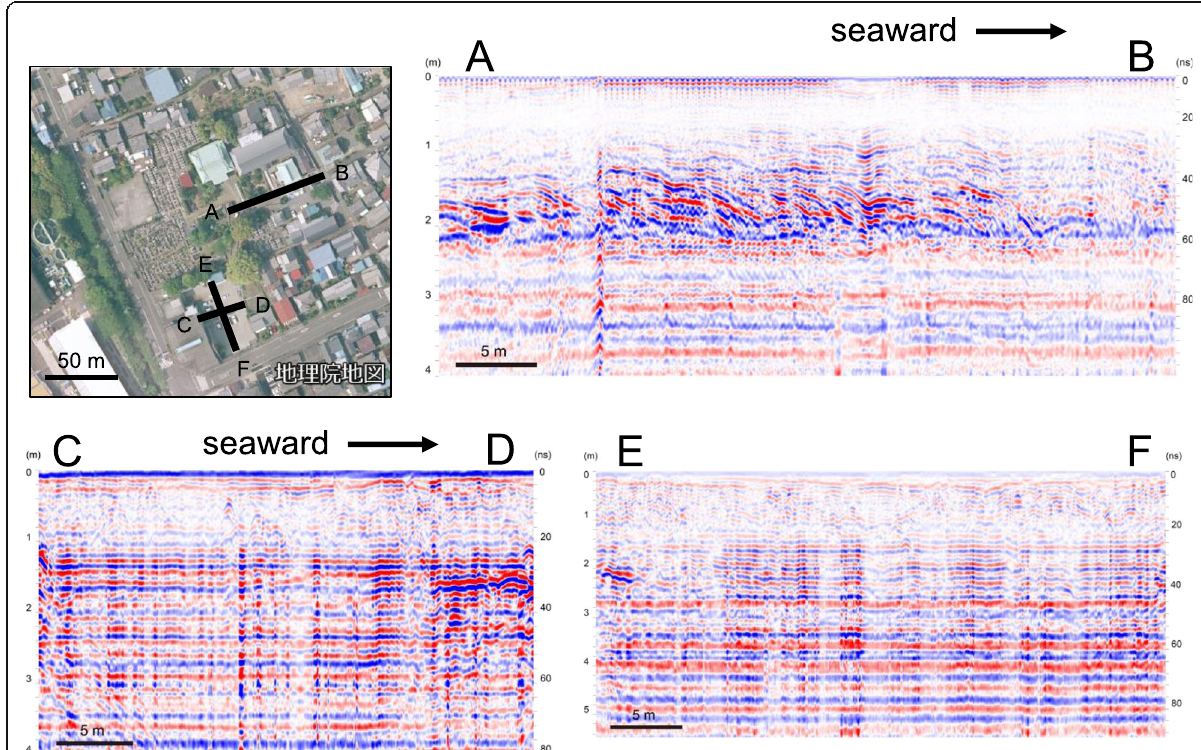
Fig. 3 Profiles obtained from a ground-penetrating radar survey. The right-hand vertical axis shows two-way travel time (ns) and the left-hand vertical axis shows estimated depth (m) for a given specific inductive capacity ( ν ; 14.0, 9.0, and 6.0 for profiles A − B, C − D, and E − F,